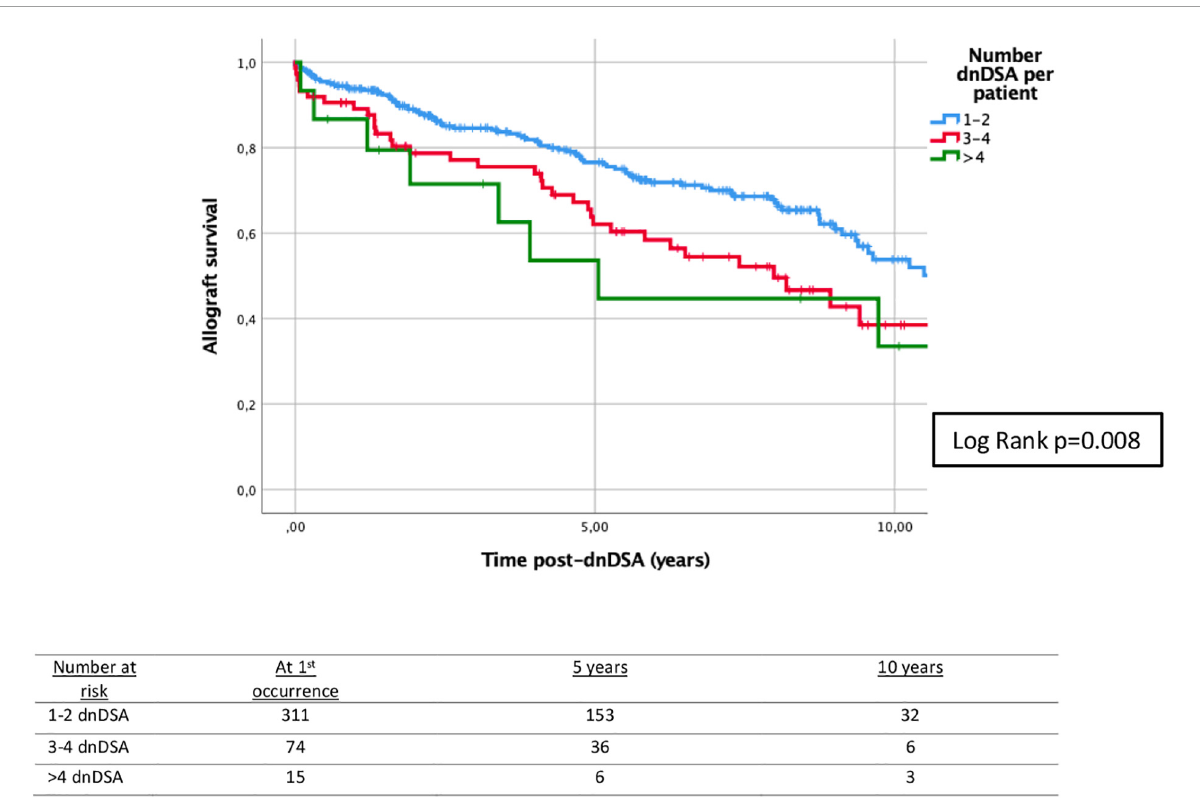
FIGURE3 Kaplan–Meier survival analysis of death-censored graft failure for the number of dnDSA/patient after the first occurrence of the first dnDSA. Five-year death-censored allograft survival post-dnDSA: 76.6% ( ± 2.7%) for patients with 1–2 dnDSA; 62.1% ( ± 6.1%) for patients with 3–4 dnDSA; and 53.6% ( ± 14.2%) for patients with > 4 dnDSA. Log-rank p = 0.008. dnDSA, de novo donor-specific